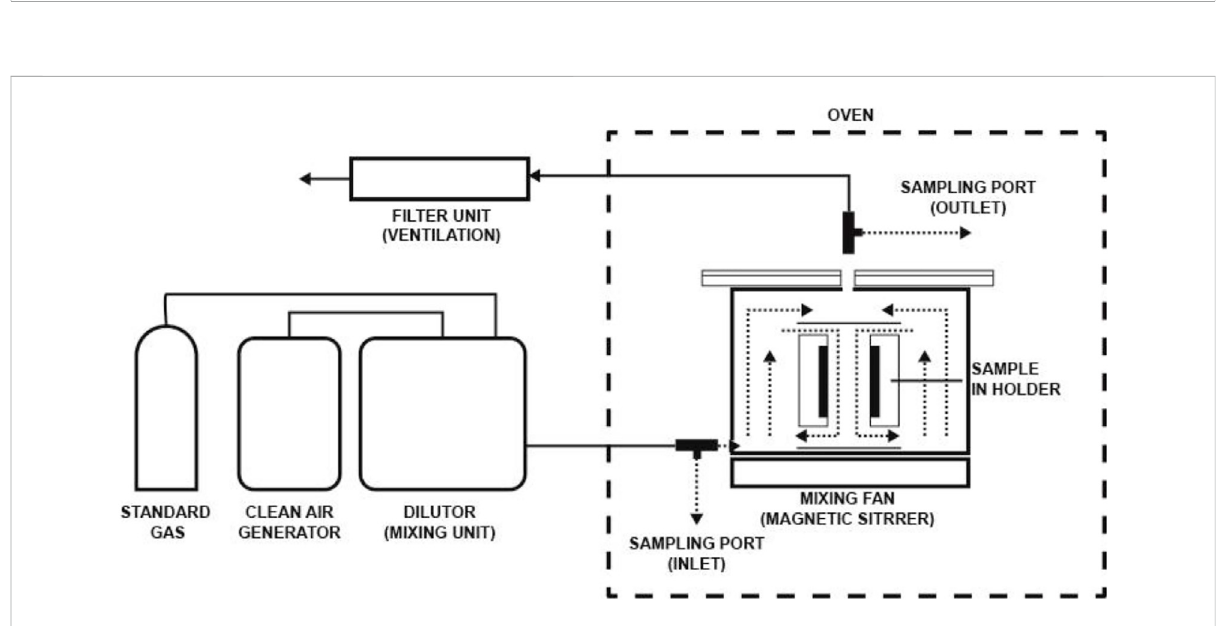
FIGURE 2 Diagram of HCHO adsorption test with 20 L small